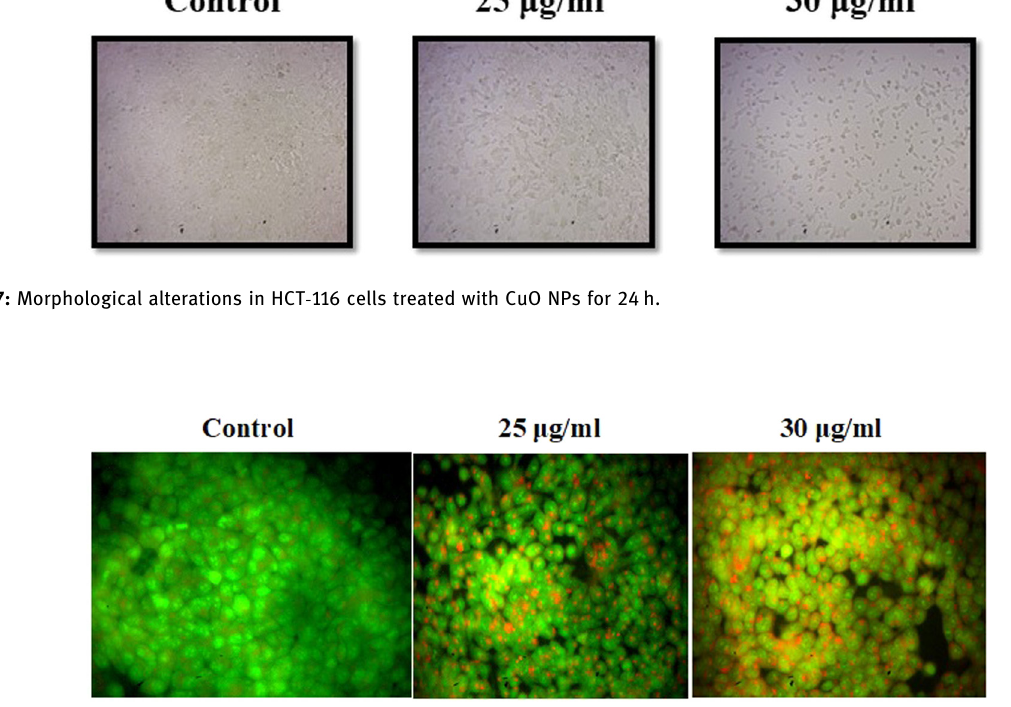
Figure 8: Induction of apoptosis as a result of CuO NPs treatment in HCT - 116